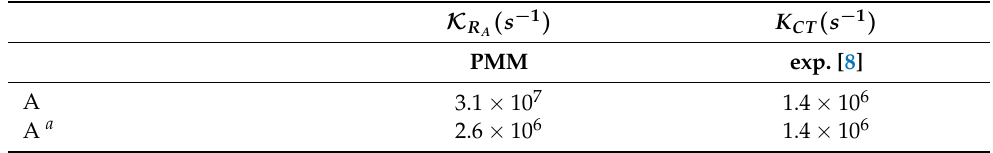
Table 5. Comparison between the calculated kinetic constant K R (obtained removing from the mean A transition energy the solvent contribution) and the experimentally measured rate constant K CT for the interstrand charge transfer of the G . + –A–C 3 sequence containing substrates. In this case, the electron 2 donor, G 3 Guanine base, is in the complementary strand. When not specified the data refer to fully removed solvent